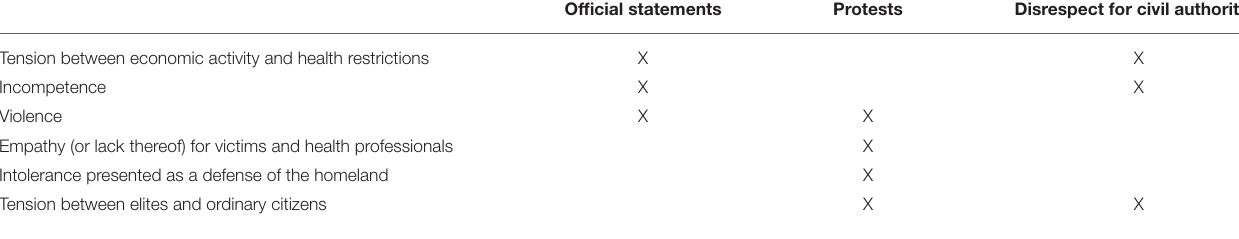
TABLE 2 | Emphasis frames in event categories.